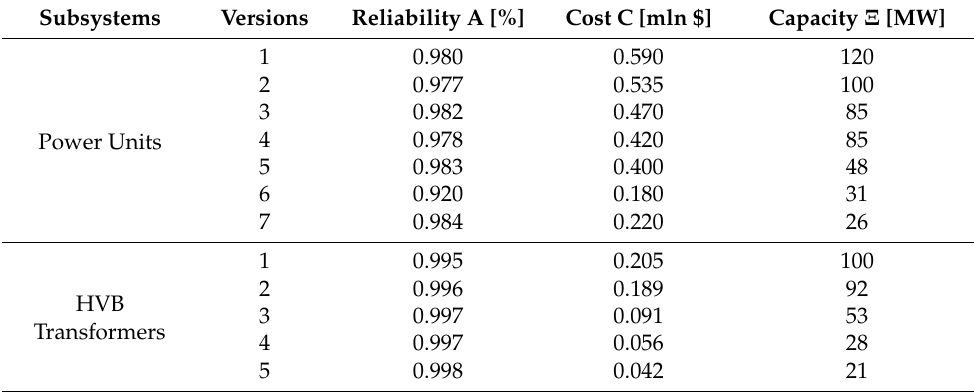
Table 3. Characteristics of the system elements available